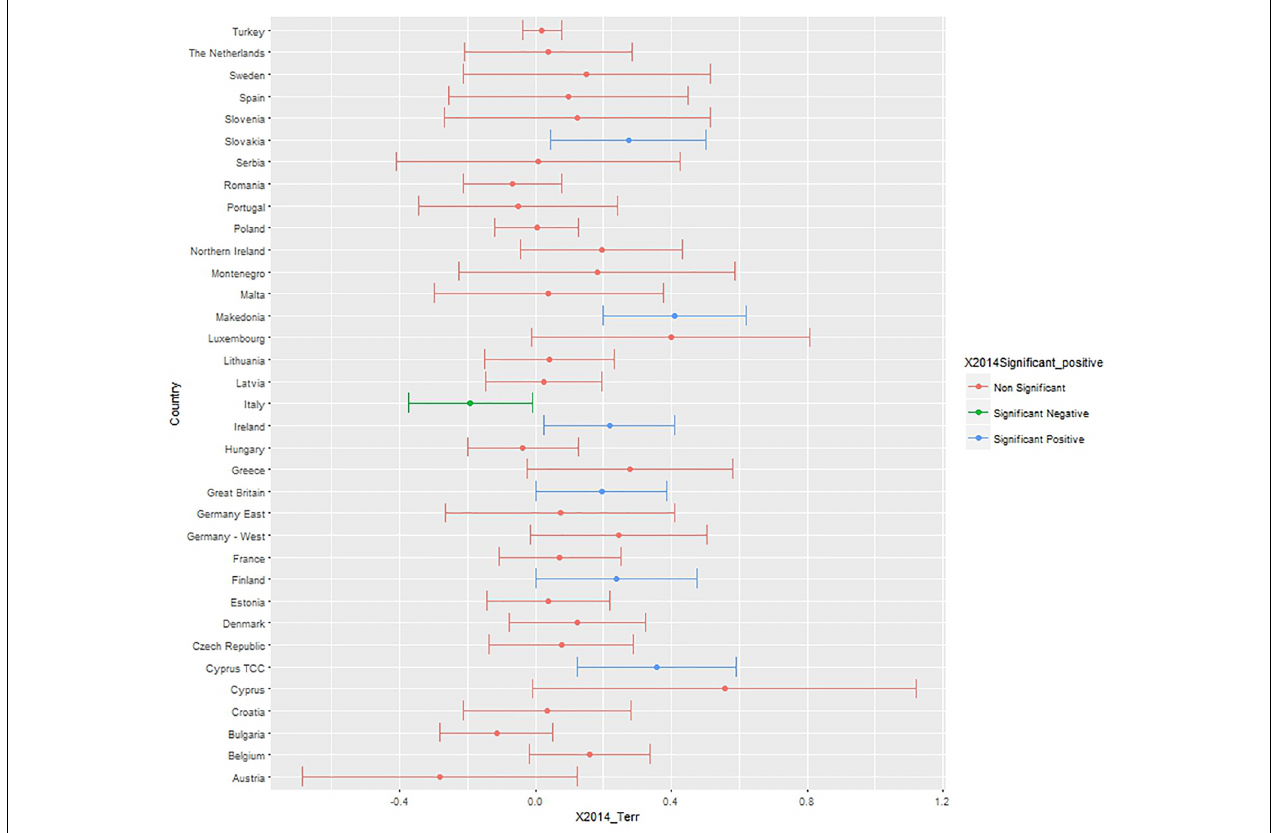
FIGURE 1 | Unstandardized B and confidence intervals of the terrorism threat coefficient predicting negative attitudes toward the EU, controlling for age, gender, political orientation, realistic, and symbolic threats. Data: Eurobarometer